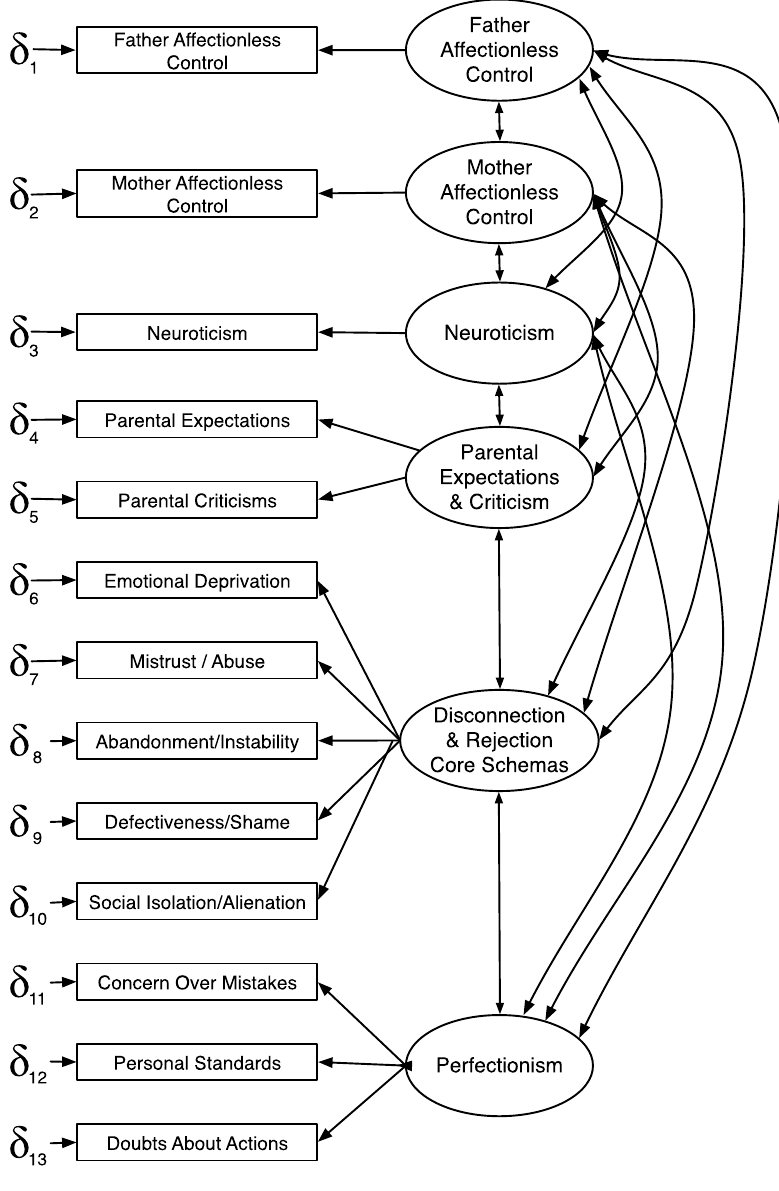
Figure 2. The measurement model.